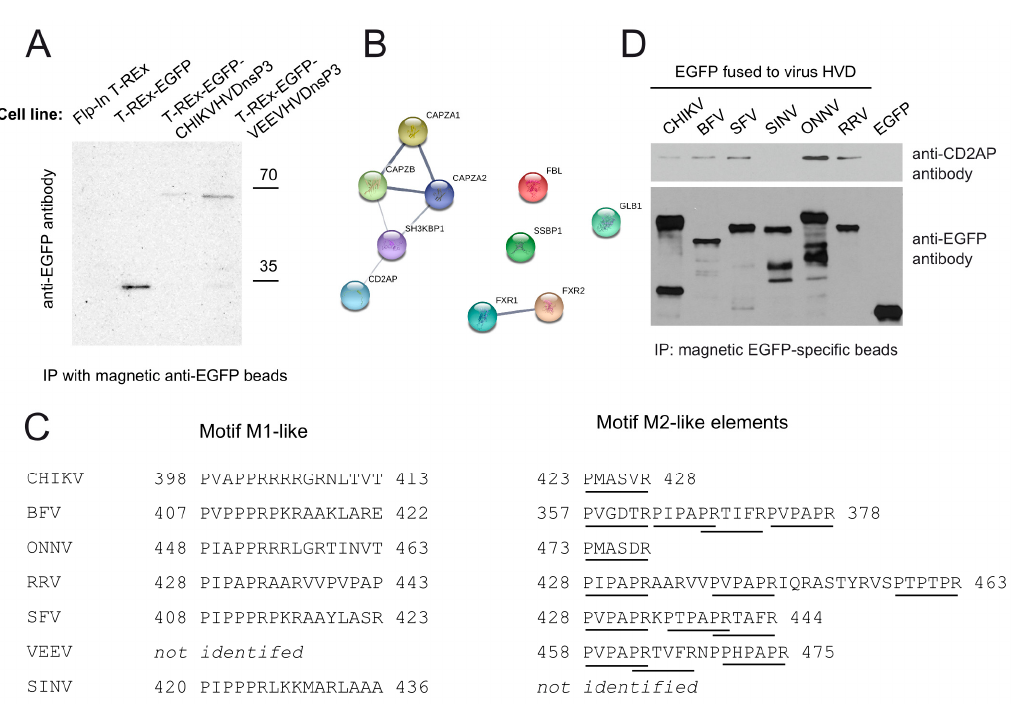
Figure 3. Binding of CD2AP by nsP3 HVDs of different alphaviruses. ( A ) Western blot analysis of immunoprecipitated samples obtained from Flp-In T-Rex, T-Rex-EGFP, T-Rex-EGFP- immunoprecipitated samples obtained from Flp-In T-Rex, T-Rex-EGFP, CHIKVnsP3HVD and T-Rex-EGFP-VEEVnsP3HVD cells with anti-EGFP antibody; ( B ) Network